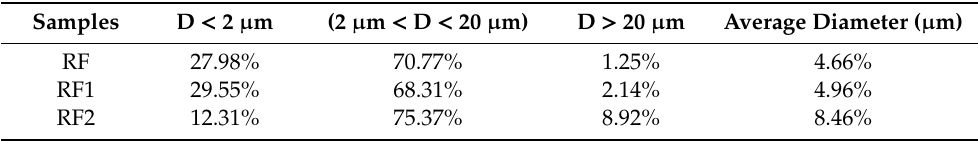
Figure 3. Granulometric analysis of the clays: ( a ) Frequency, and ( b ) cumulative values. Table 2. Granulometric compositions and average sizes of particles measured from the RF, RF1, and RF2 samples.